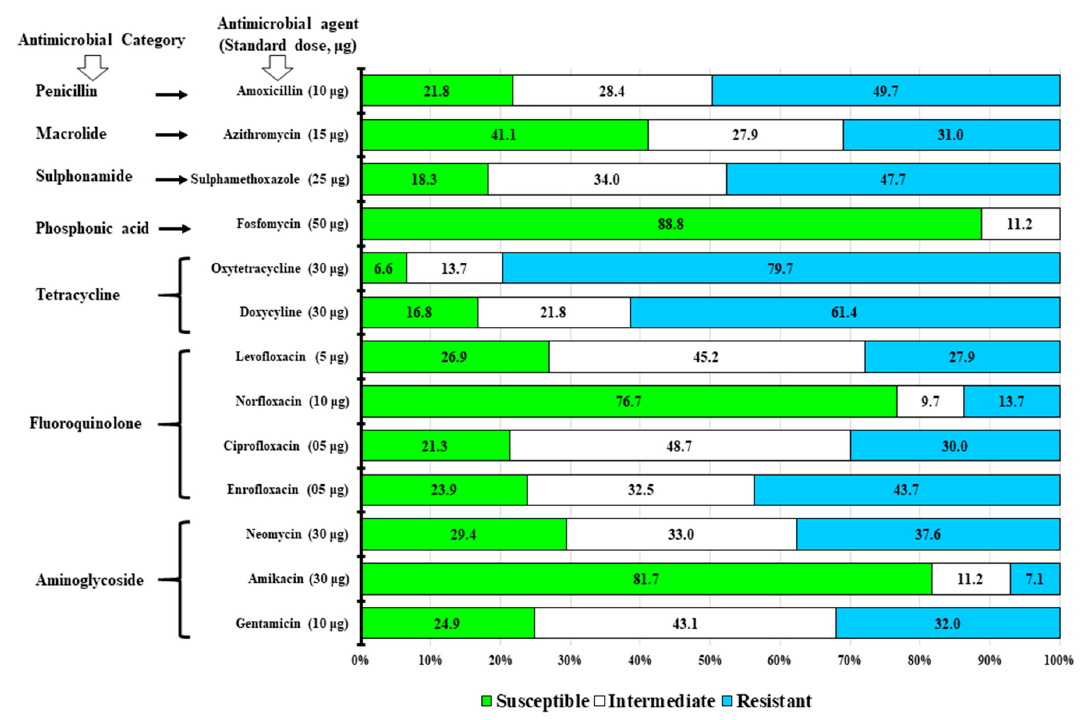
Figure 4. Antimicrobial susceptibility test results of Salmonella Gallinarum ( n = 197) isolated from the non-vaccinated layer flocks. A total of 13 antimicrobial agents under seven groups of antimicrobials were used at standard doses ( µ g): Amoxycillin (10 µ g), Azithromycin (15 µ g), Sulfamethoxazole (25 µ g), Fosfomycin (50 µ g), Oxytetracycline (30 µ g), Doxycycline (25 µ g), Levofloxacin (5 µ g), Norfloxacin (10 µ g), Ciprofloxacin (5 µ g), Enrofloxacin (5 µ g), Neomycin (30 µ g), Amikacin (30 µ g), and Gentamicin (10 µ g). Three categories (susceptible, intermediate, and resistant) of the resistant pattern in accordance to Clinical and Laboratory Standards Institute (CLSI) [42] were estimated. Table 6. Antimicrobial resistance patterns of Salmonella Gallinarum isolated from the layer flocks. Resistance Against Antimicrobials Resistance